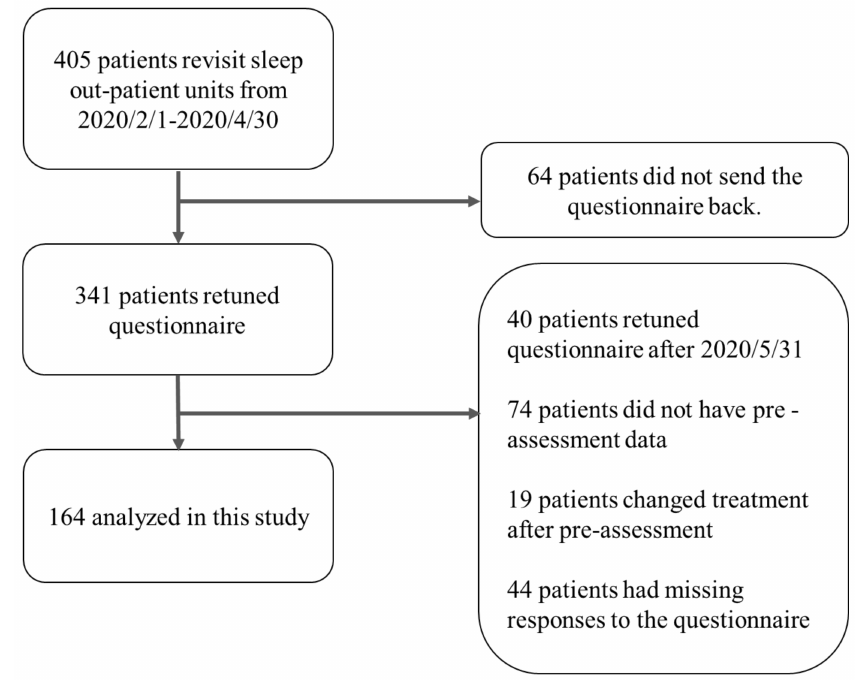
Figure 1. A flowchart of this